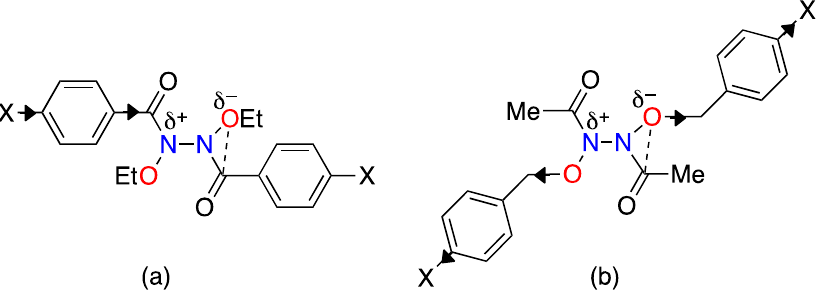
Figure 14. Influence on the HERON transition state of ( a ) electron-rich benzoyl groups in 19 and ( b ) electron-deficient benzyloxy groups in 20 .